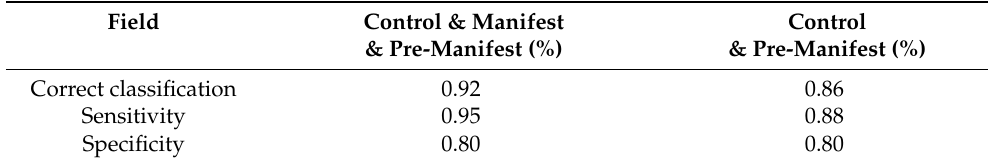
Table 2. Forecasting accuracy results.The second column shows the results using control, pre-manifest and manifest cases while the third column includes only control and pre-manifest